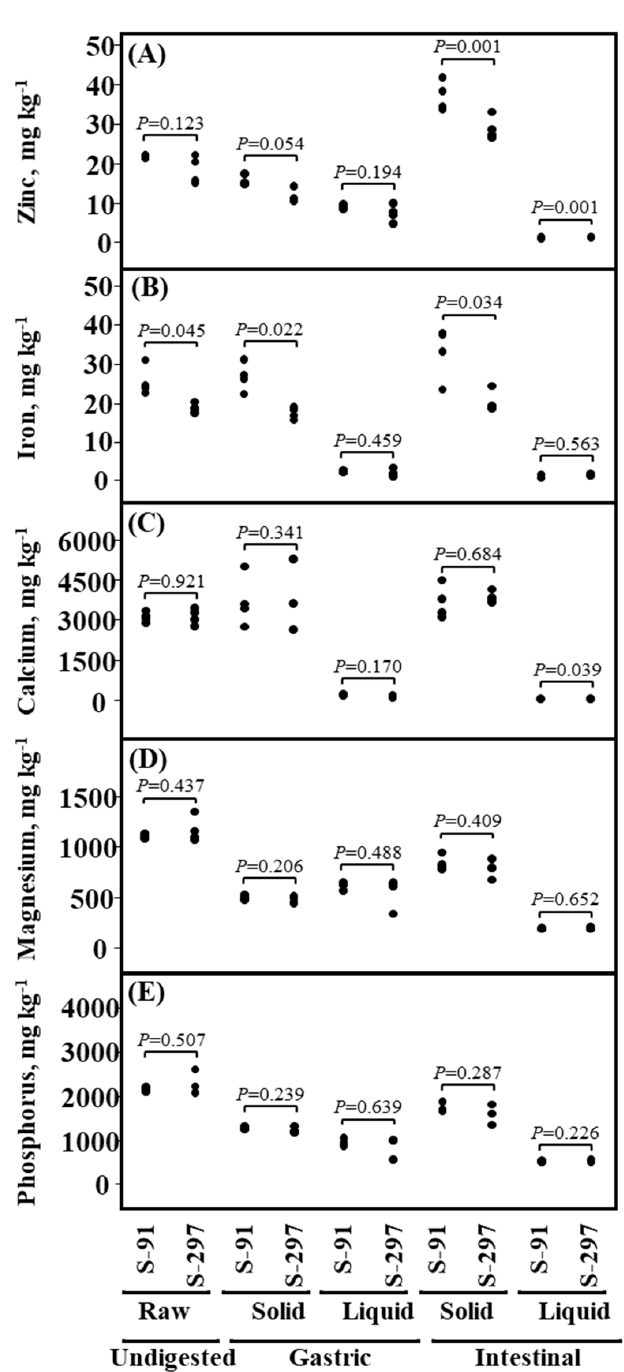
Figure 4. Bio-accessibility of mineral–nutrients between S-91 and S-297 lines. In vitro digestion of seed paste for ( A ) zinc, ( B ) iron, ( C ) calcium, ( D ) magnesium and ( E ) phosphorus concentrations in the different phases of the digest (Undigested, Gastric and Intestinal) in each fraction (Raw sample, Solid and Liquid). P -values indicate differences between the two genotypes (S-91 and S-297) as determined by t -test ( n = 4).